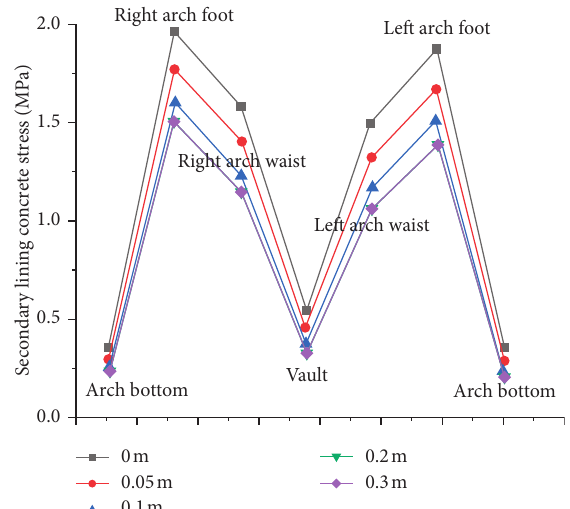
Figure 11: The maximum principal stress of lining structure.